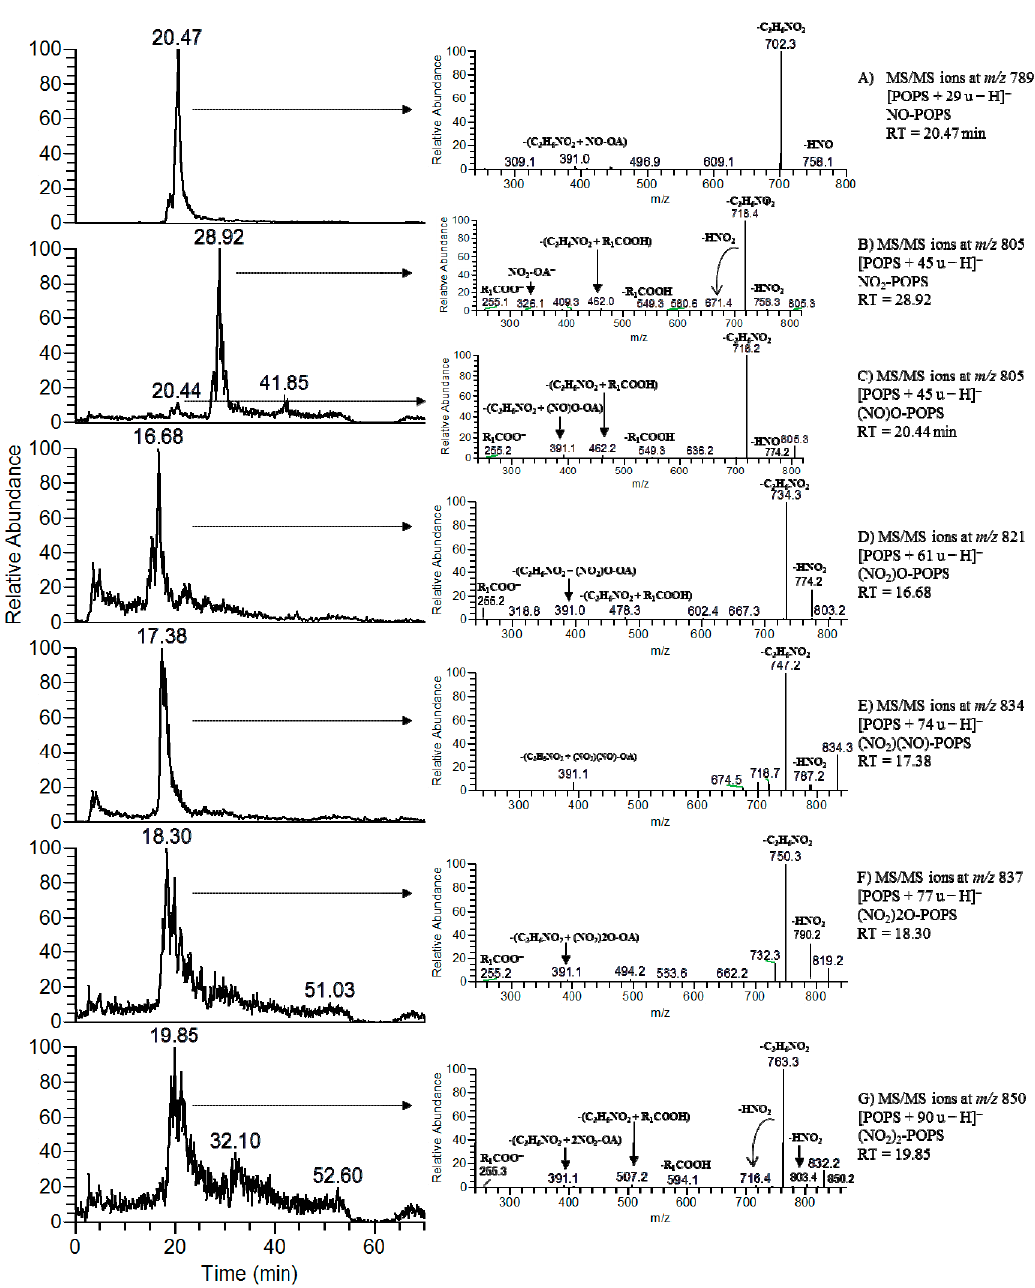
Figure 3. Reconstructed ion chromatogram (RIC) and LC-MS/MS spectra ( A – G ) of nitrated and nitroxidized derivatives of POPS at m/z 789 identified as nitroso POPS (RT 20.47 min) ( A ), isobaric compounds at m/z 805 identified as nitro (RT 28.92) ( B ) and nitrosohydroxy POPS (20.44 min) ( C ), at m/z 821 identified as nitrohydroxy POPS (RT 16.68 min) ( D ), at m/z 834 identified as nitronitroso POPS (RT 17.38 min) ( E ), at m/z 837 identified as nitrohydroperoxy POPS (RT 18.30 min) ( F ), and at m/z 850 identified as dinitro POPS (RT 19.85 min) ( G ).